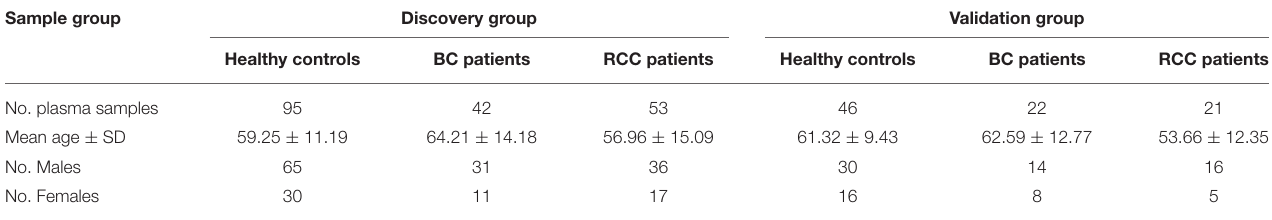
TABLE 1 | Demographics of cancer (BC and RCC) patients and healthy controls. Sample group Discovery